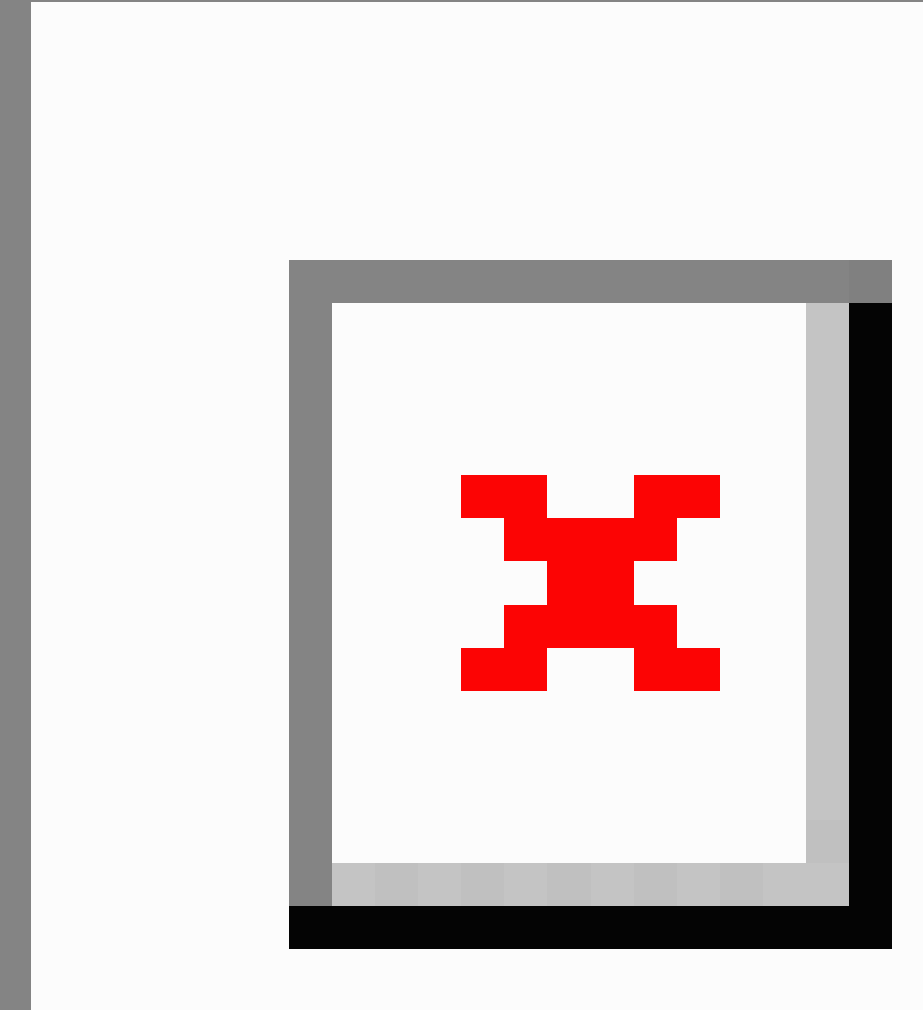
Figure 7. The View Posts